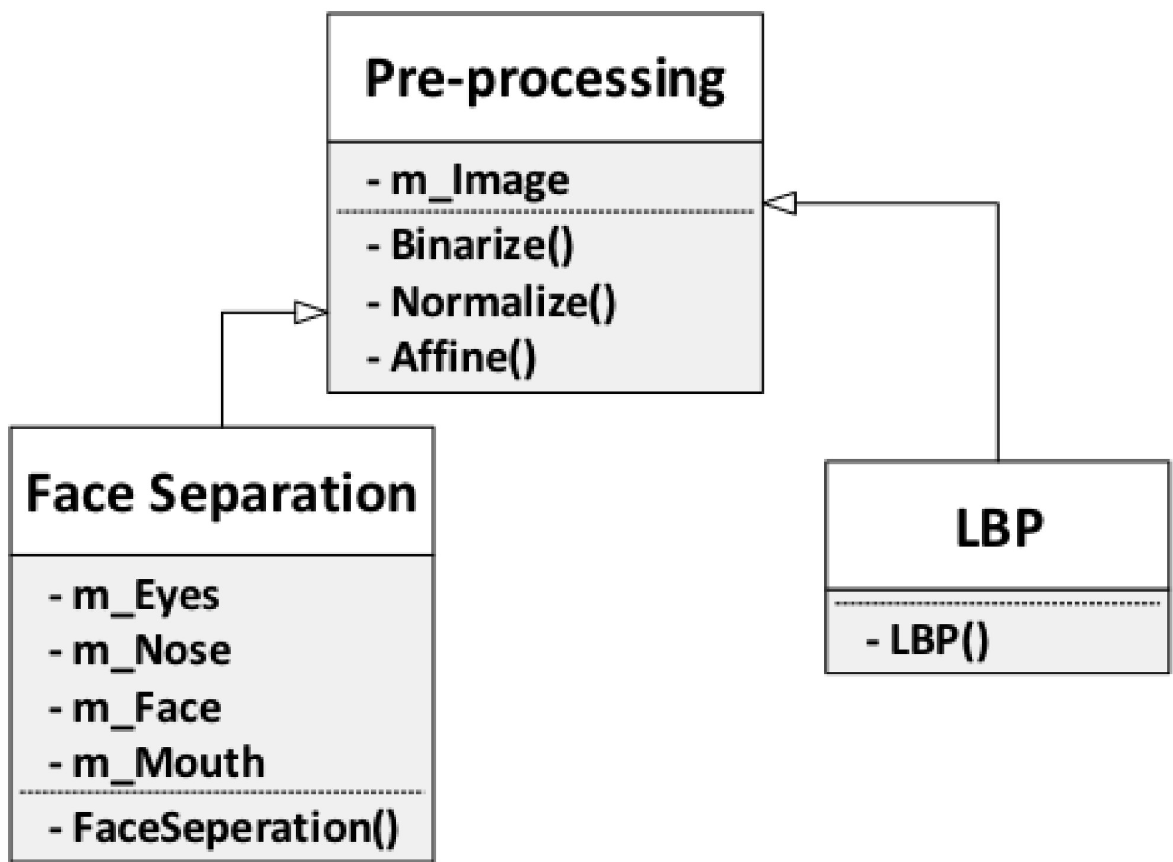
Fig 11. Pre-processing.